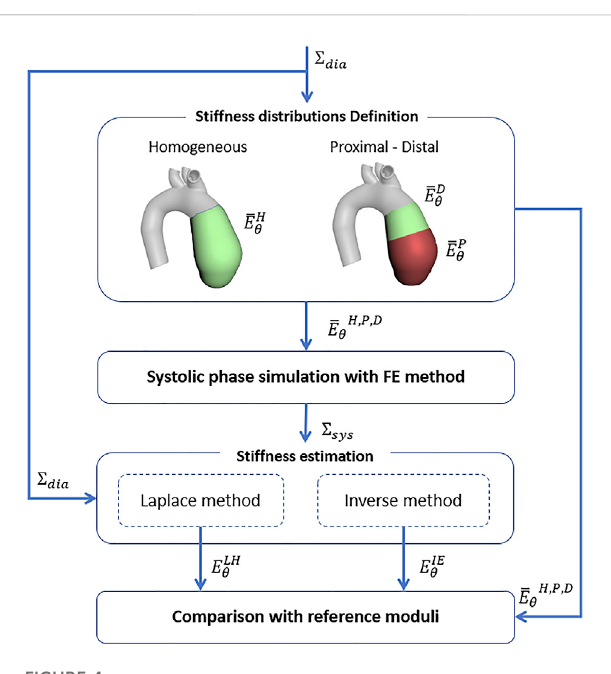
FIGURE 4 Numerical validation work fl ow for the stiffness estimation algorithm on the basis of FE